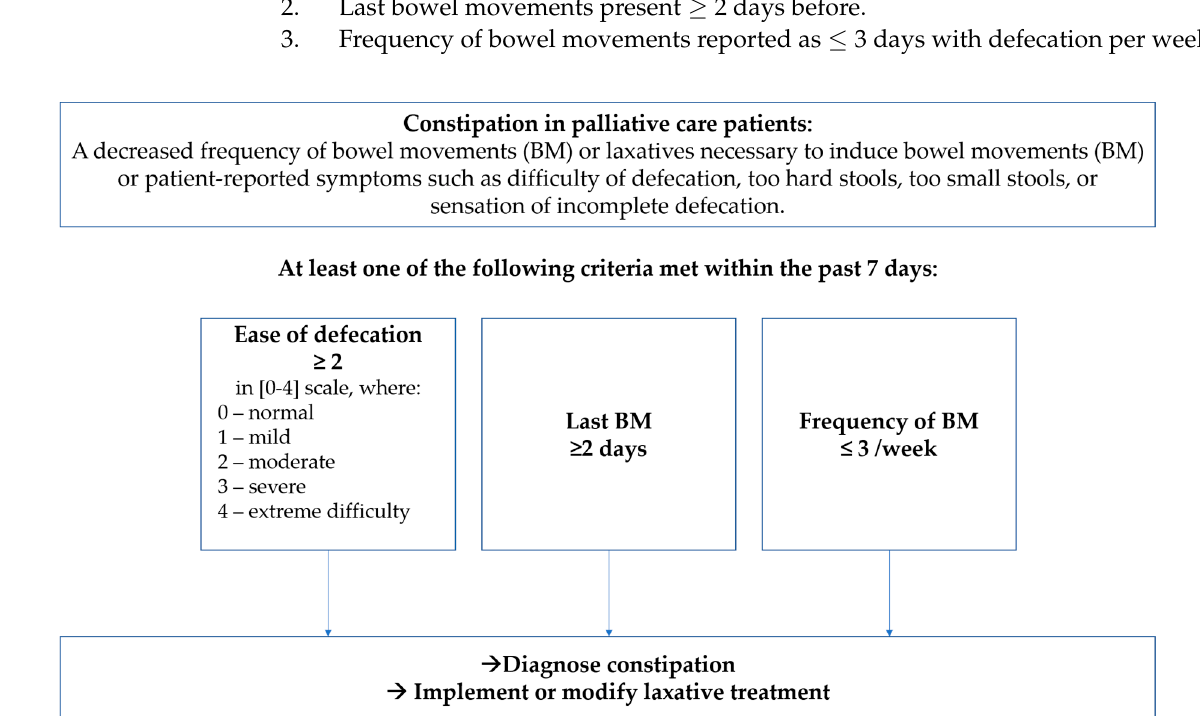
Figure 2. The proposed algorithm ELF-7 for the diagnosing of